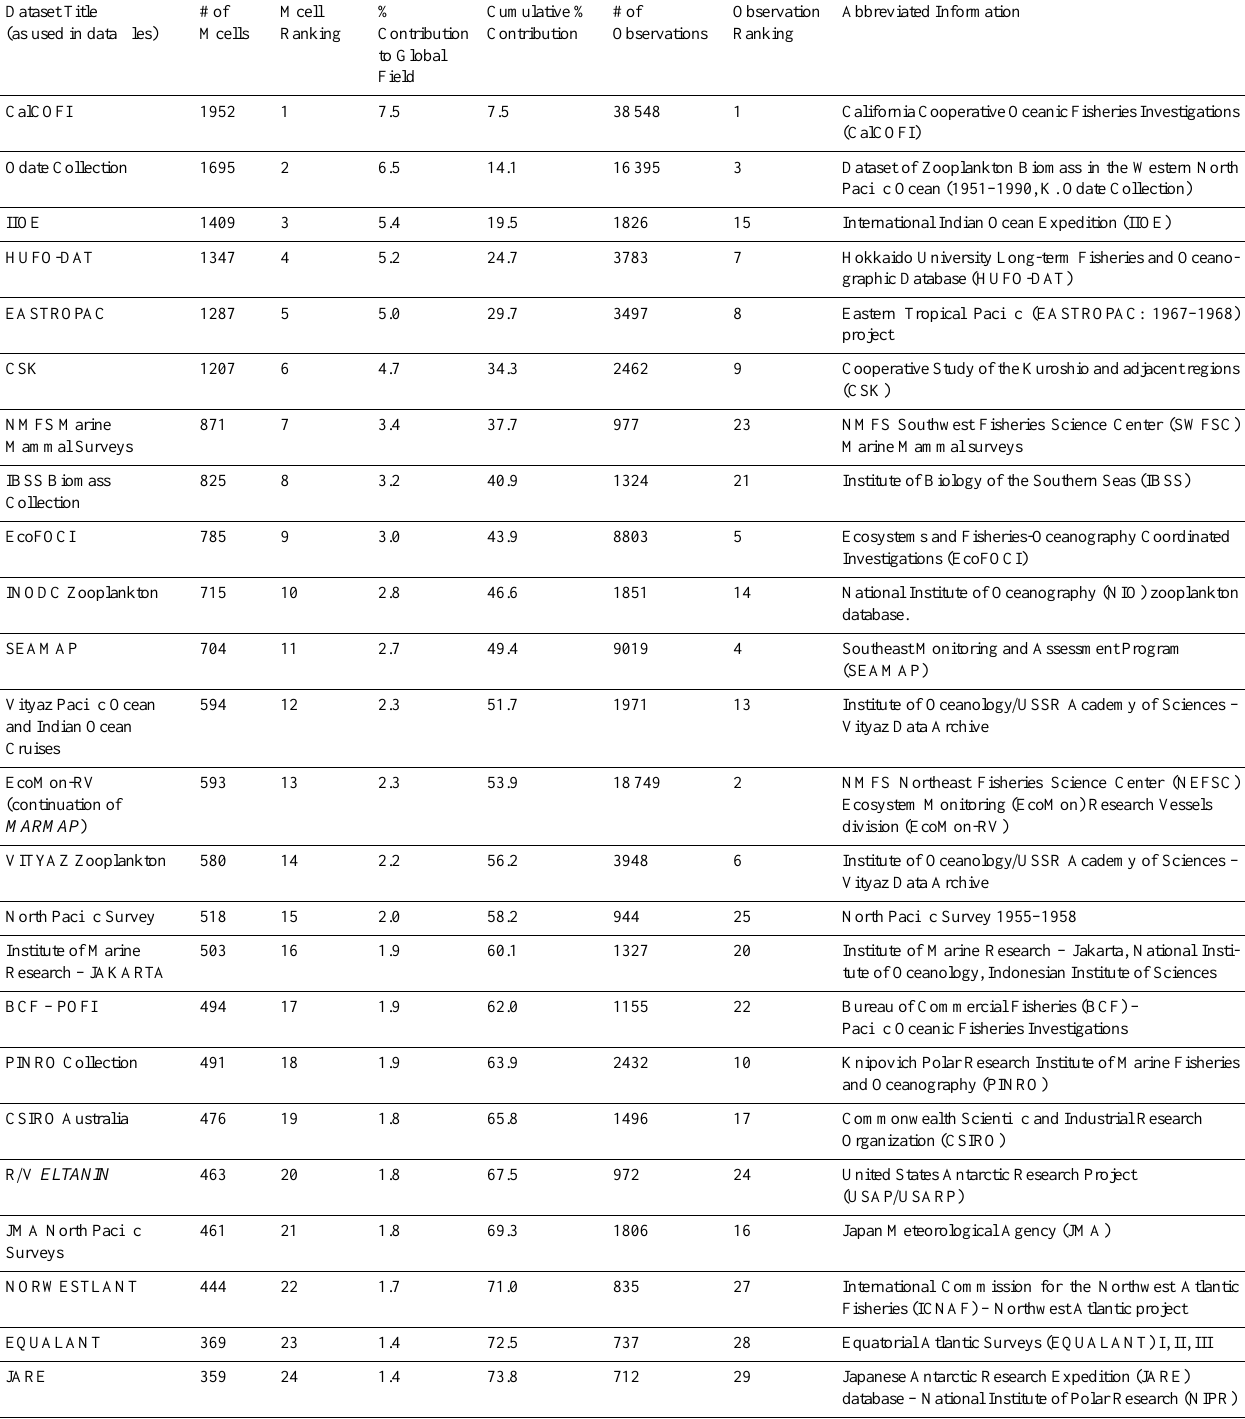
Table 1. Sources for COPEPOD mesozooplankton biomass and biovolume data. Dataset Title (as used in data